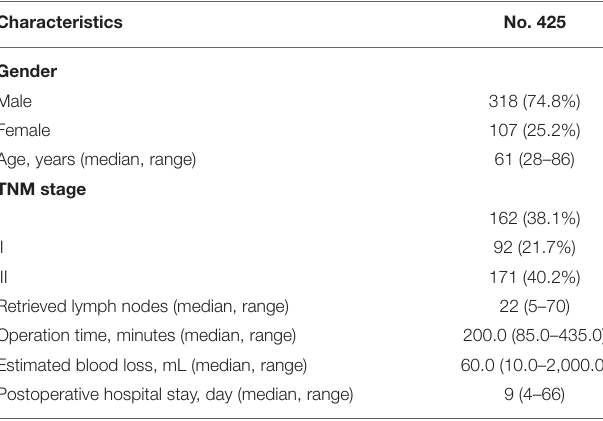
TABLE 1 | Clinical characteristics of the